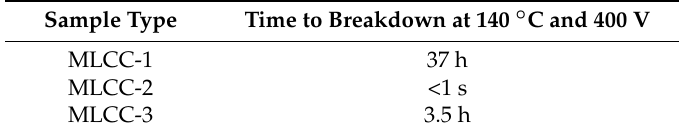
Table 2. Time-to-breakdown for the MLCC at the initial HALT test conditions.